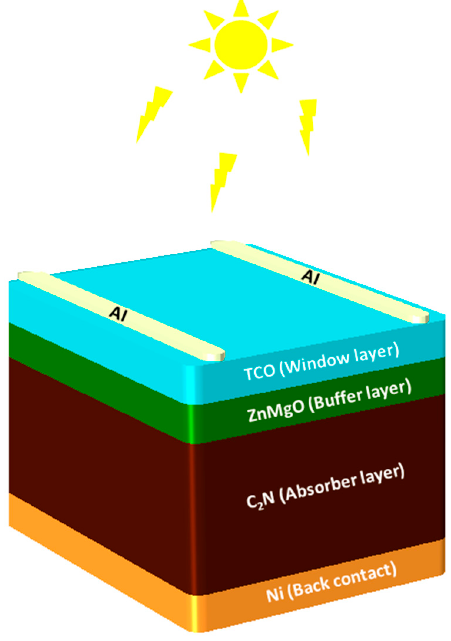
Figure 2. Schematic view of a C 2 N-based solar cell. Table 1 . Initial key input parameters for the SCAPS-1D simulation .